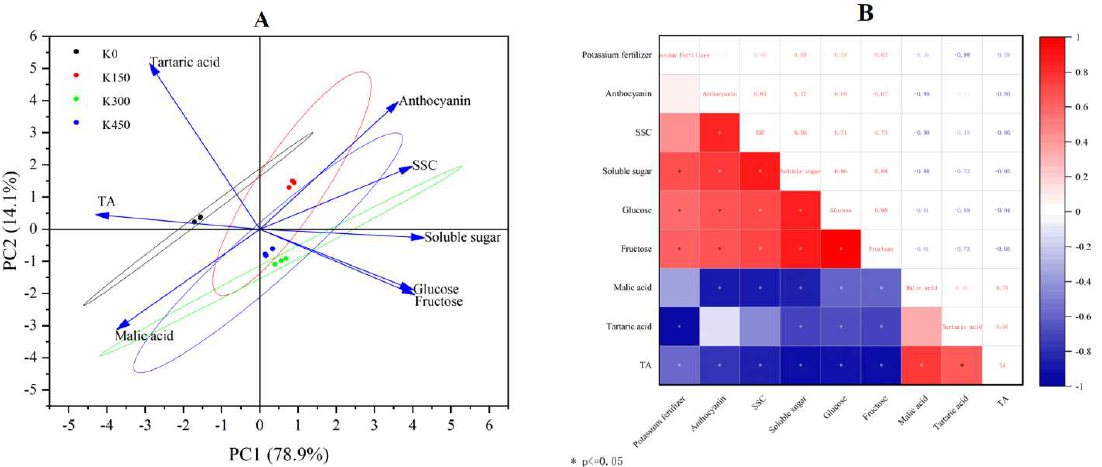
Figure 5. ( A ): Principal component analysis; ( B ): correlation analysis (red represents positive correlation, blue represents negative correlation, the shade of color represents the degree of correlation, and * represents p ≤ 0.05).